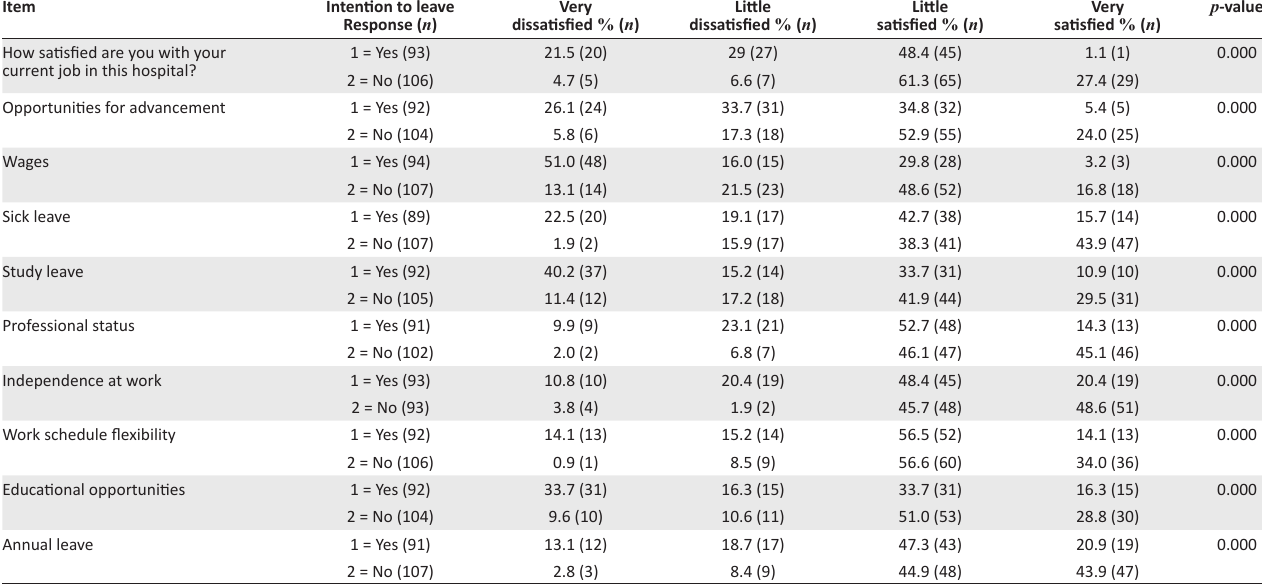
TABLE 6: Relationship between overall job satisfaction and intention to leave ( n =